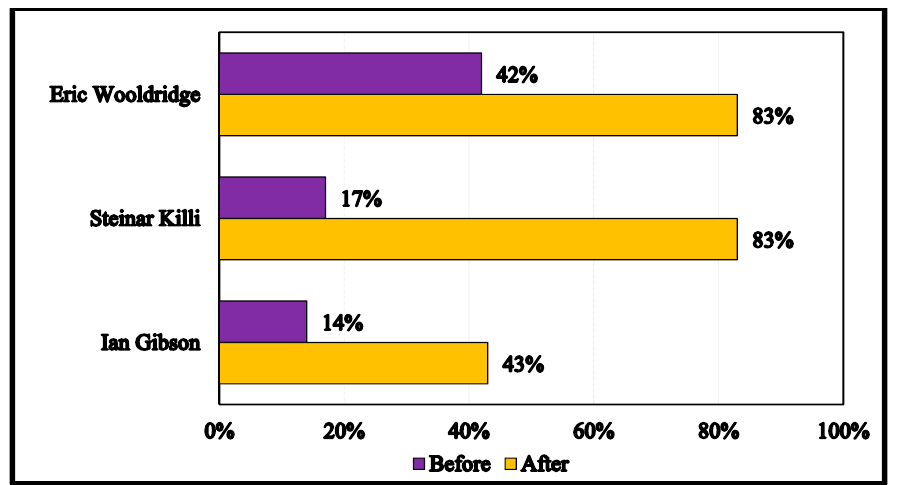
Figure 17. Percentage of respondents who reported a proficient or advanced understanding of the topic before and after each lecture.